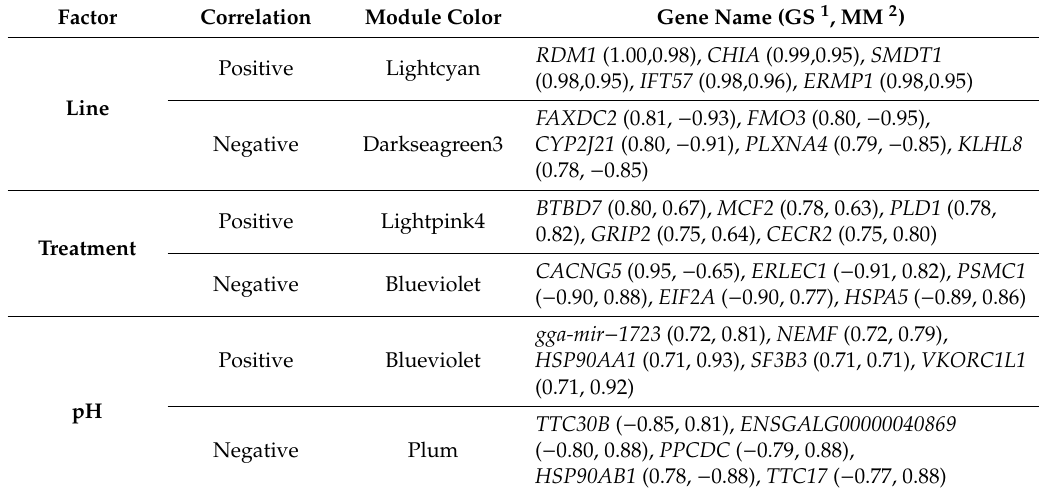
Table 6. Top five driver genes for gene modules that were significantly associated with a factor (line, treatment or blood phenotypes) for the AH